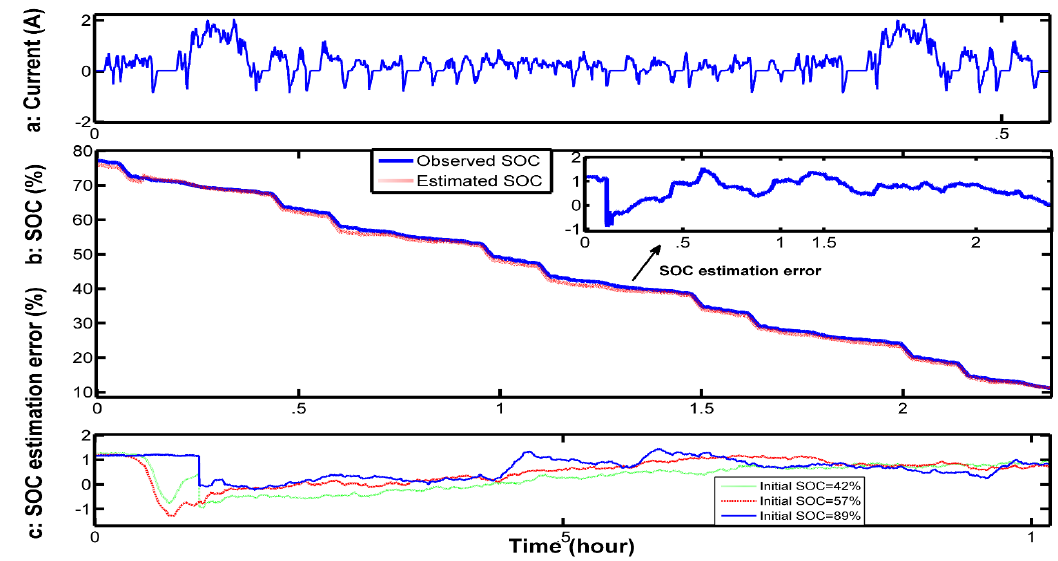
Figure 11. Estimated voltage error of the battery pack for about 2 hours before and after applying proposed method discharging with FTP-75 current profile from initial 89% SOC.